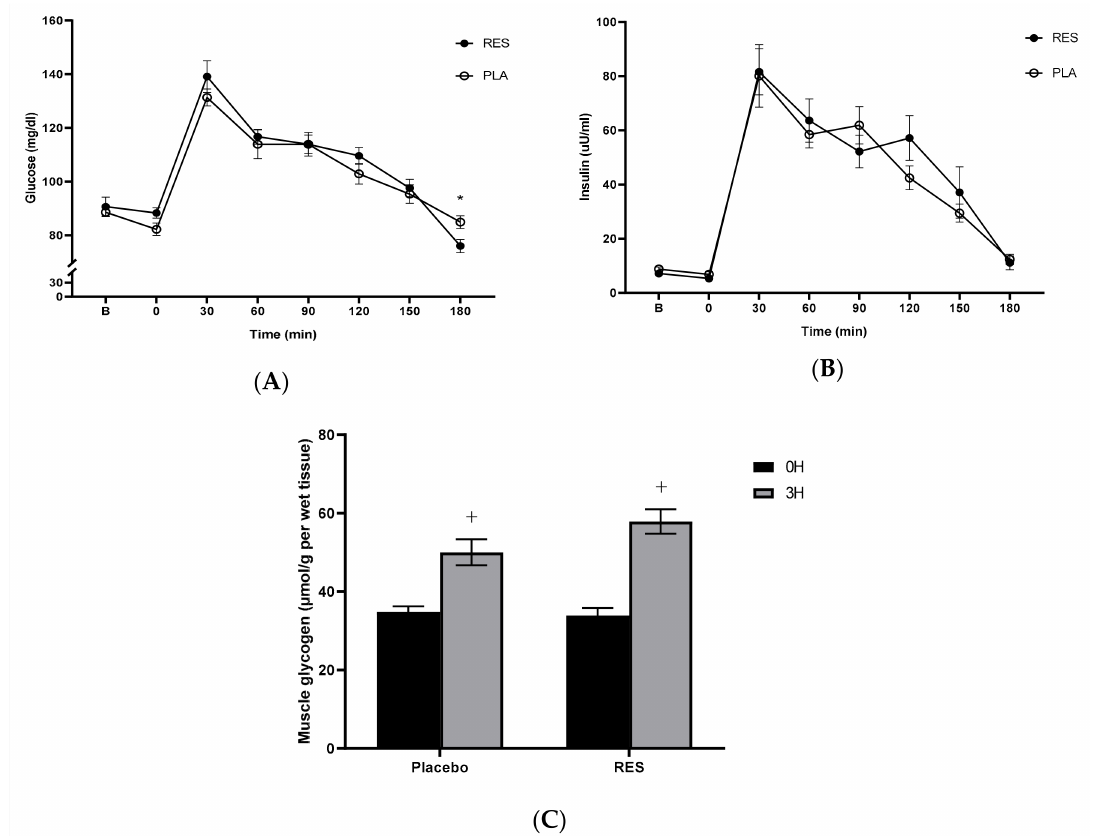
Figure 2. Blood glucose ( A ), insulin concentrations ( B ) and glycogen levels ( C ) after a single bout